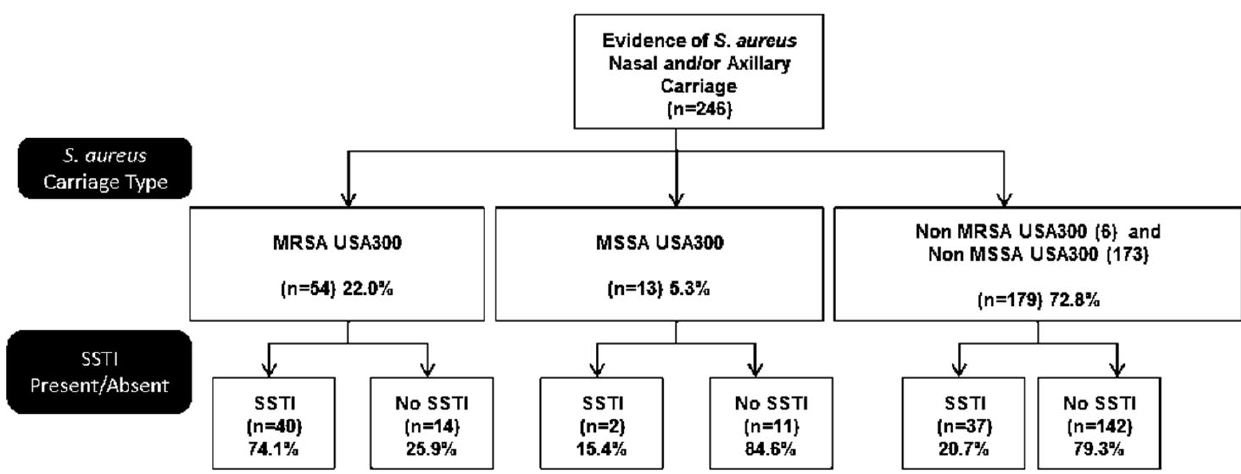
Figure 3. Distribution of nasal and axillary S. aureus carriage types between SSTI and no-SSTI groups. Note: No S. aureus carriage was detected in 668 swabs taken from either nasal, axillary areas: 96/668 were from SSTI group and 572/668 were from No SSTI group. SSTI, skin and soft tissue infection; MRSA, methicillin resistant Staphylococcus aureus